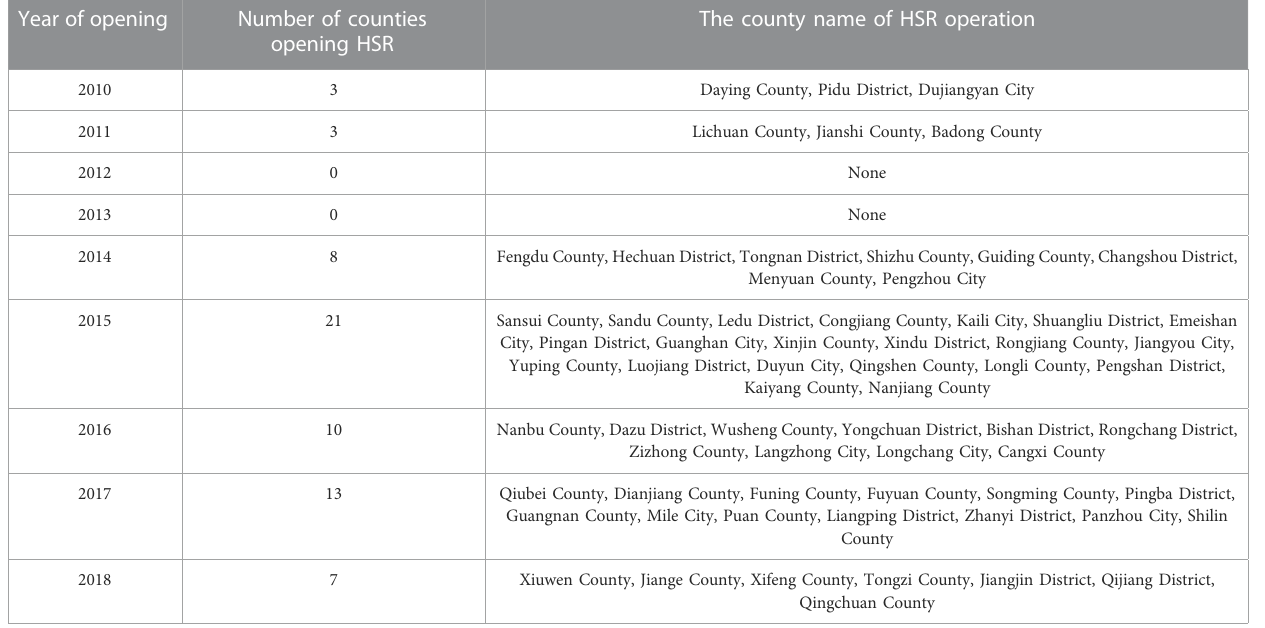
TABLE 2 The timeline of HSR operation in the upper Yangtze River counties (as of